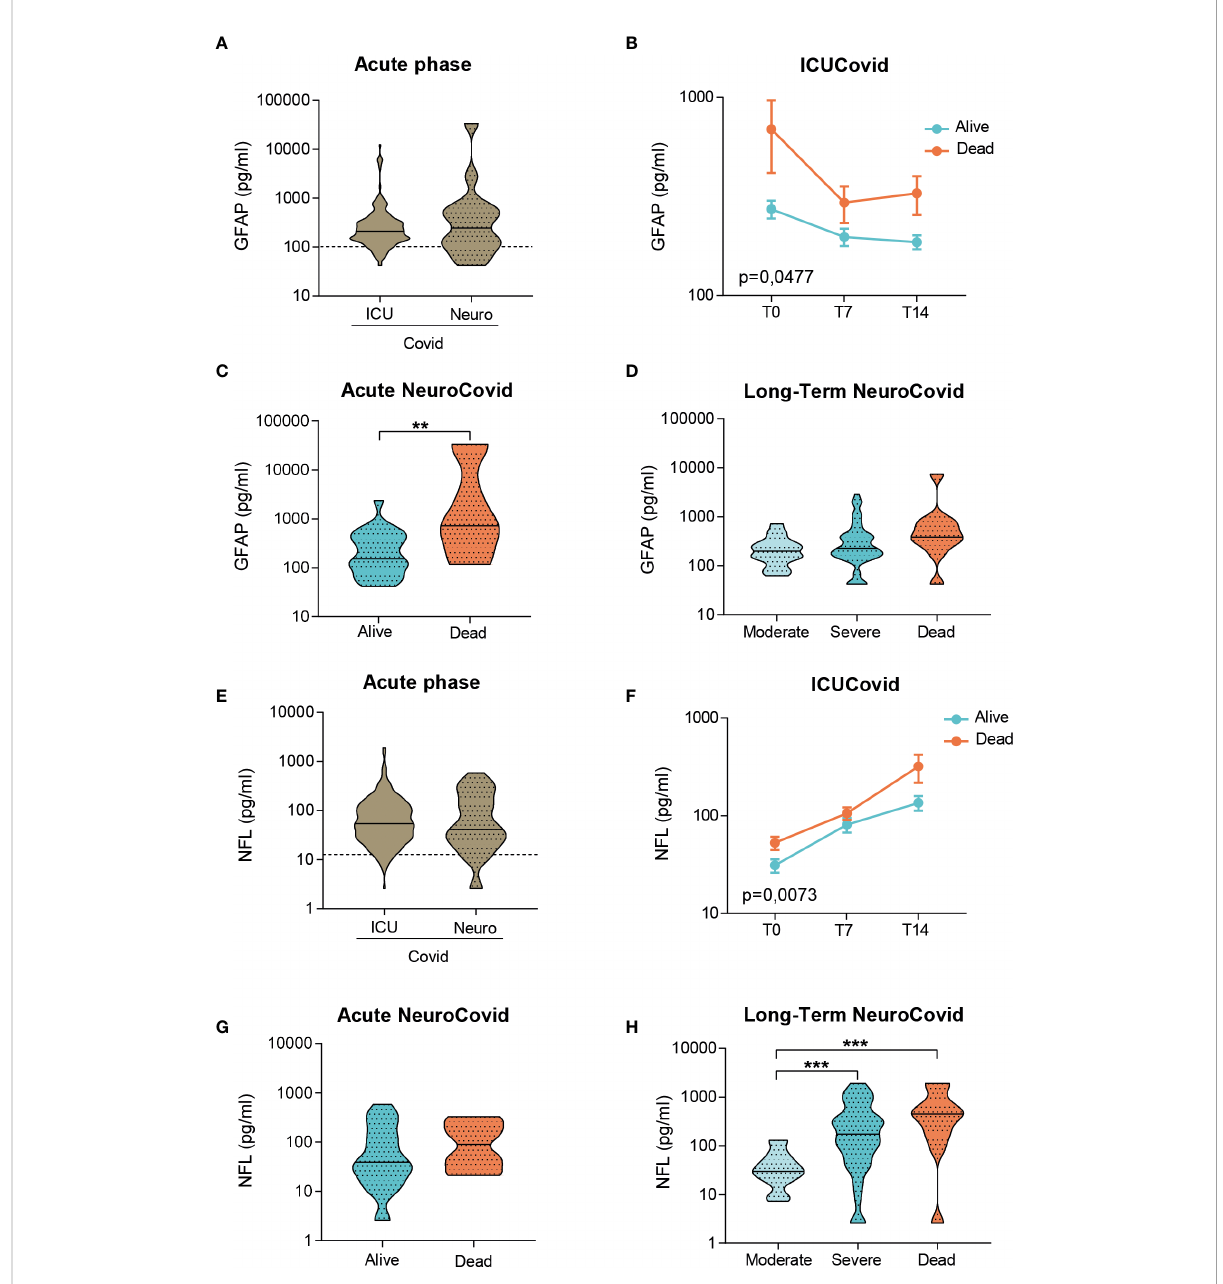
FIGURE 4 Analysis of GFAP and NFL in plasma of two cohorts of COVID-19 patients. (A-H) GFAP (A-D) and NFL (E-H) concentrations were measured by Simoa technology in plasma samples from two cohorts of COVID-19 patients. (A, E) Violin plots represent the median, variability and probability density of GFAP (A) and NFL (E) at acute phase, in ICUCovid (n=79) and NeuroCovid samples (n=31). Dotted line indicates the mean level of healthy controls. (A) Mann Whitney, p=0.7910; (E) Mann Whitney, p=0.7054. (B, F) The concentrations of GFAP (B) and NFL (F) were measured in ICUCovid patients over time, at ICU admission (T0) and after 7 (T7) and 14 days (T14). ICUCovid patients were strati fi ed as alive (n=32) and dead (n=14). Data (mean ± SEM) indicate biomarker concentrations. (B) Two-way ANOVA for repeated measures, p = 0.0477; **p < 0.005 alive versus dead at T0 by Sidak ’ s post hoc test; (F) Two-way ANOVA for repeated measures, p=0.0073; ***p < 0.001 alive versus dead at T14 by Sidak ’ s post hoc test. (C, G) The concentrations of GFAP (C) and NFL (G) were measured at acute phase, in samples from NeuroCovid patients, strati fi ed as alive (n=23) and dead (n=8). Violin plots indicate median, variability and probability density of biomarker concentrations. (C) Mann Whitney, **p= 0.0088; (G) Mann Whitney, p=0.2868. (D, H) The concentrations of GFAP (D) and NFL (H) in long-term samples from NeuroCovid patients, strati fi ed as moderate (n=18), severe (n=42) and dead (n=8). Violin plots indicate median, variability and probability density of biomarker concentrations. (D) Kruskal-Wallis, p=0.0570; (H) Kruskal-Wallis, p<0.0001. ***p < 0.001 by Dunn ’ s post hoc